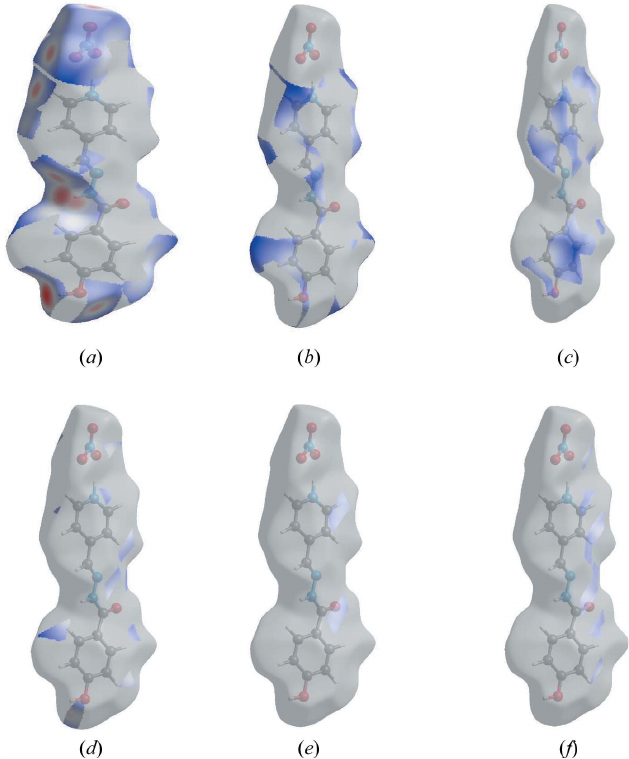
Figure 7 The Hirshfeld surface representations with the function d norm plotted onto the surface for ( a ) H (cid:2)(cid:2)(cid:2) O/O (cid:2)(cid:2)(cid:2) H, ( b ) H (cid:2)(cid:2)(cid:2) H, ( c ) H (cid:2)(cid:2)(cid:2) C/C (cid:2)(cid:2)(cid:2) H, ( d ) H (cid:2)(cid:2)(cid:2) N/N (cid:2)(cid:2)(cid:2) H, ( e ) C (cid:2)(cid:2)(cid:2) C and ( f ) C (cid:2)(cid:2)(cid:2) N/N (cid:2)(cid:2)(cid:2) C interactions.